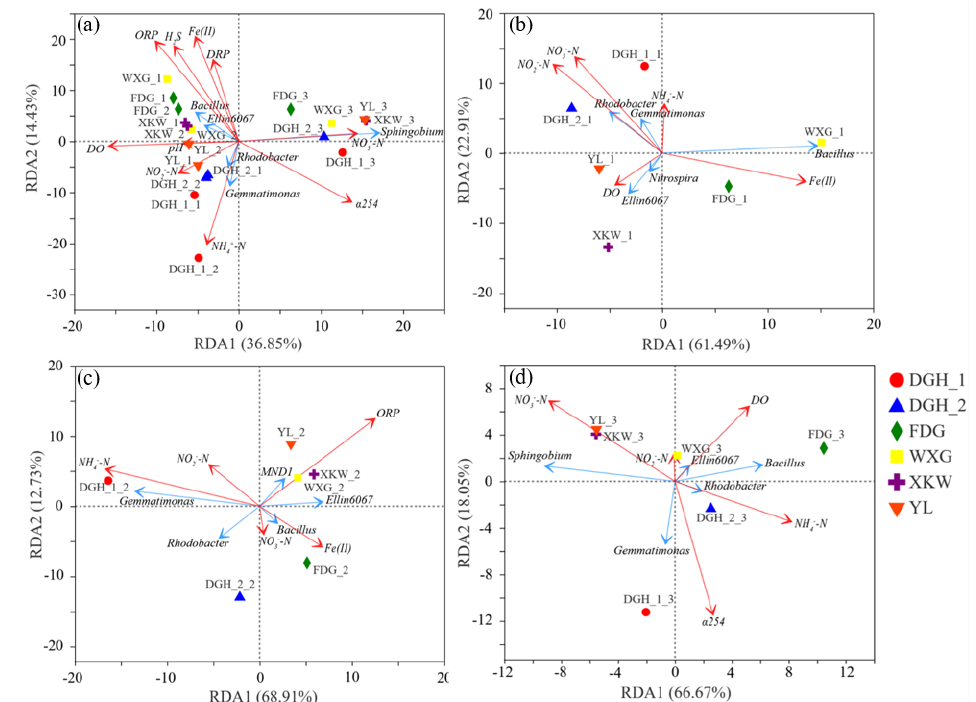
Figure 5. Redundancy analysis plot of the relationship among the nitrogen transform bacteria and dominant environmental parameters in sediment cores at 0–9 cm ( a ), surficial sediment at 0–3 cm ( b ), intermediate sediment at 3–6 cm ( c ) and profundal sediment at 6–9 cm ( d ). Red solid lines indicate major environmental variables. Blue solid lines show the top five bacteria in relative abundance at genus level. Geometric graphs represent the sampling location. (For interpretation of the references to color in this figure legend, the reader is referred to the Web version of this